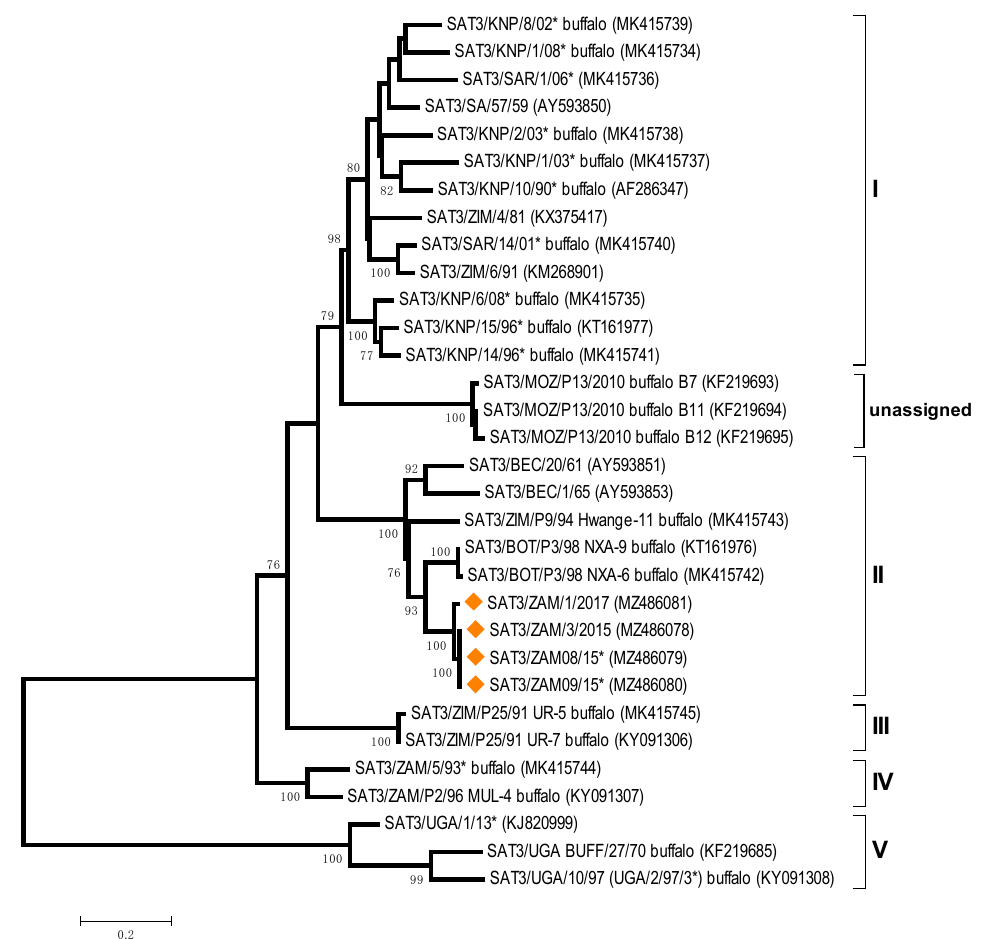
Figure 3. Midpoint-rooted maximum likelihood tree showing the relationships between the VP1 sequences of the 2015 foot-and-mouth disease virus SAT-3 serotypes from Zambia (indicated with diamonds) and other contemporary and reference viruses. * Reference number not assigned by the WRLFMD.